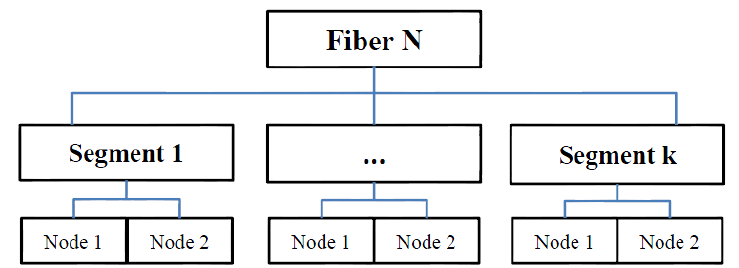
Figure 3. Object hierarchy of the computer algorithm.